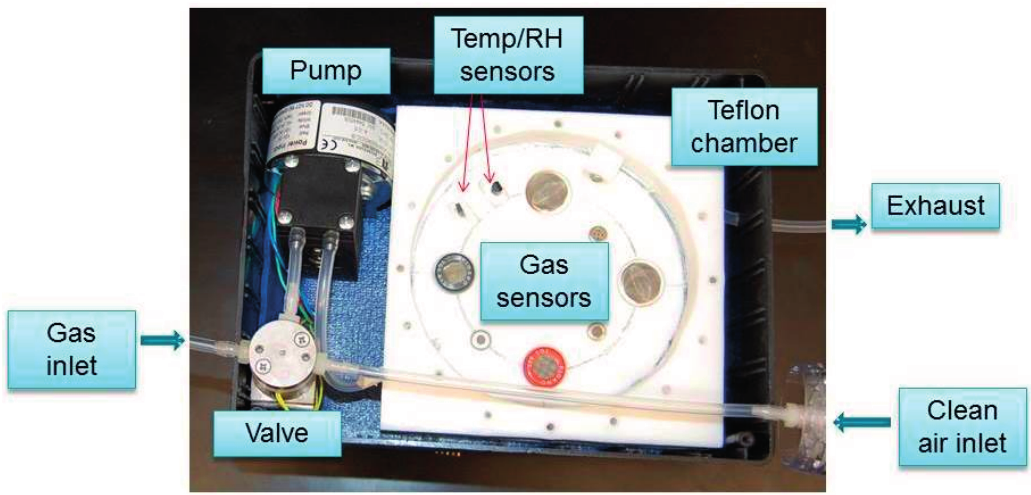
Figure 3. Top view of the mechanical component of the sensing device with top Teflon section